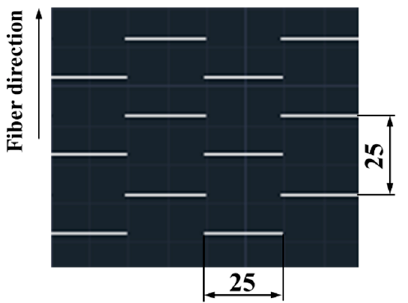
Figure 1. Unidirectional CFRP prepreg with vertical, chopped slits.